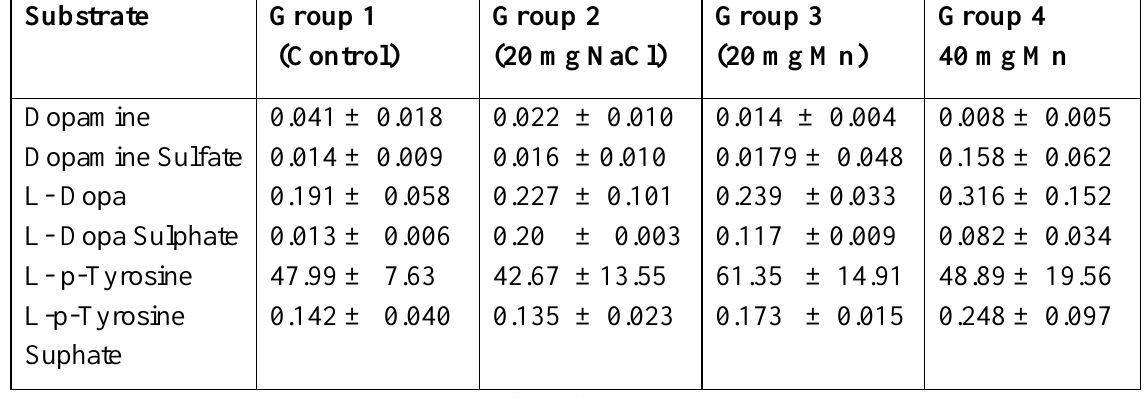
Table 1: Unsulfated and sulfated dopamine, L- Dopa, and L-p-tyrosine in the serum of different experimental groups of rats